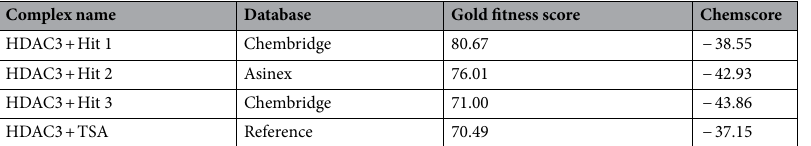
Table 4. Comparison of gold fitness score, chemscore and average binding energy of docking complexes of reference inhibitor (TSA)/Hit 1/Hit 2/Hit 3 with